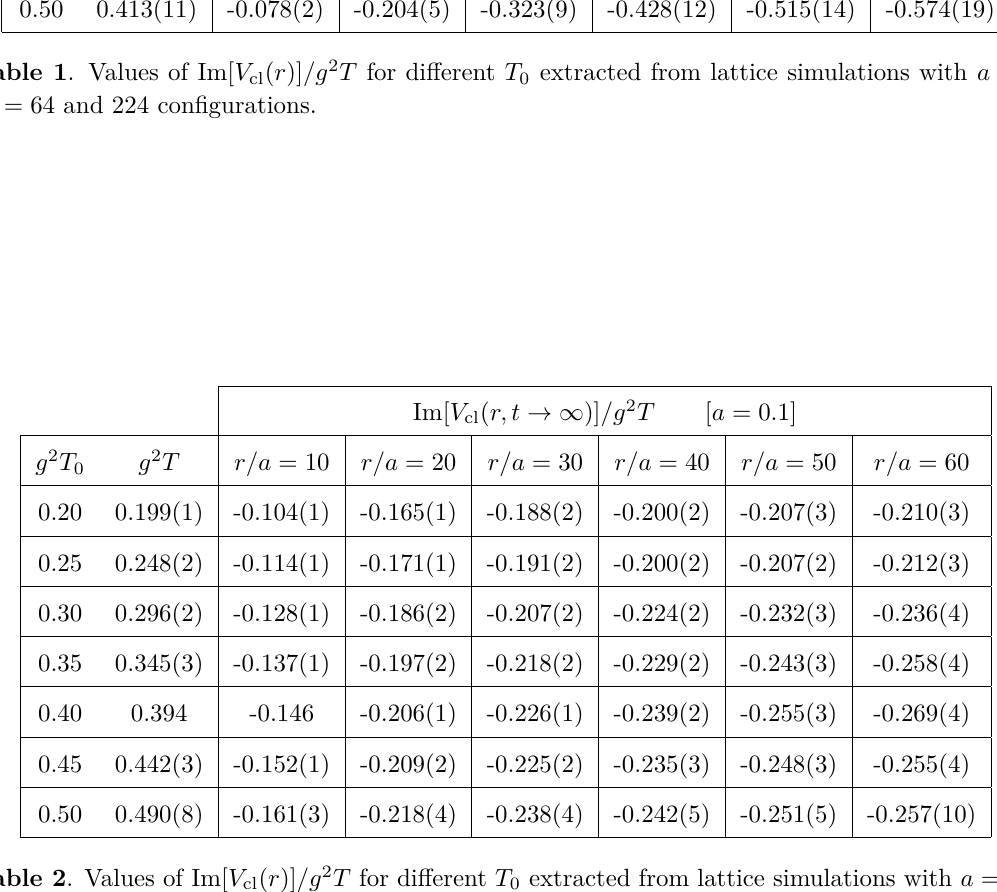
Table 2 . Values of Im[ V cl ( r )] /g 2 T for different T 0 extracted from lattice simulations with a = 0 . 1 , N = 252 (one